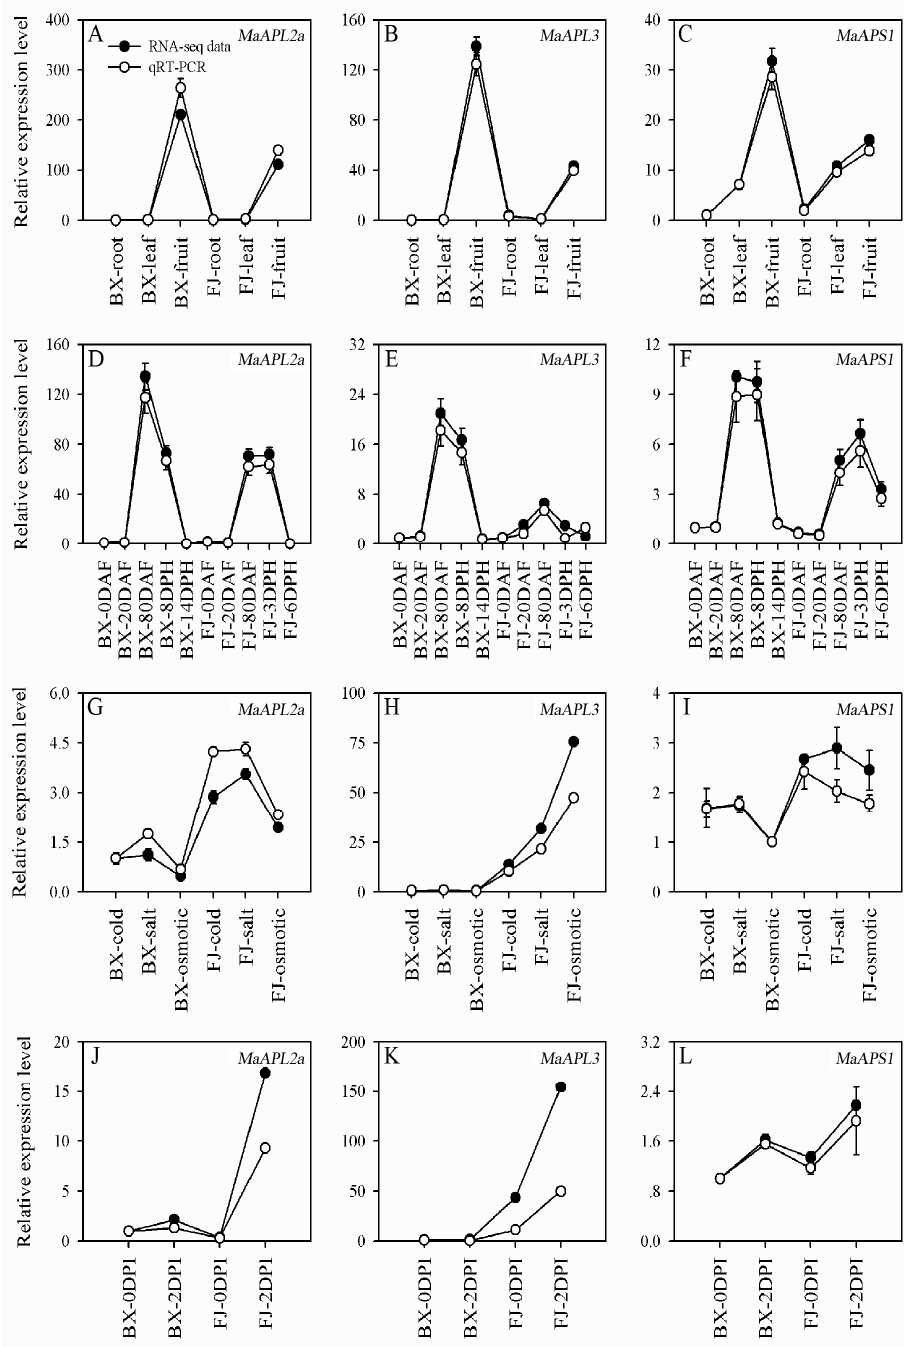
Figure 8. Relative expression of MaAGPases in two banana varieties, BX and FJ, by qRT-PCR. ( A – C ) Expression of MaAPL-2a , -3 , and MaAPS1 in different organs. ( D – F ) Expression of MaAPL-2a , -3 , and MaAPS1 at different stages of fruit development and ripening. ( G – I ) Expression of MaAPL-2a , -3 , and MaAPS1 in response to cold, salt, and osmotic stresses. ( J – L ) Expression of MaAPL-2a , -3 , and MaAPS1 in response to fungal infection. Data are presented as means ±standard deviations of n = 3 biological replicates.